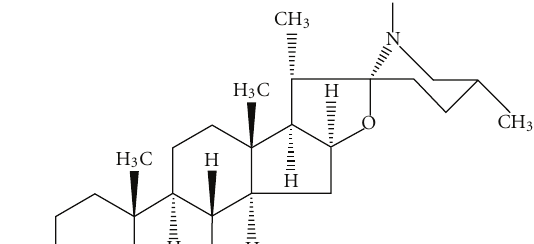
Figure 6: Structure of aegelin.